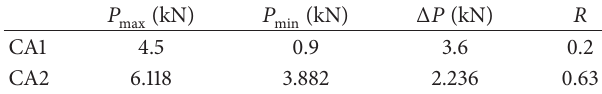
Table 2: Loading conditions related to Wu and Ni